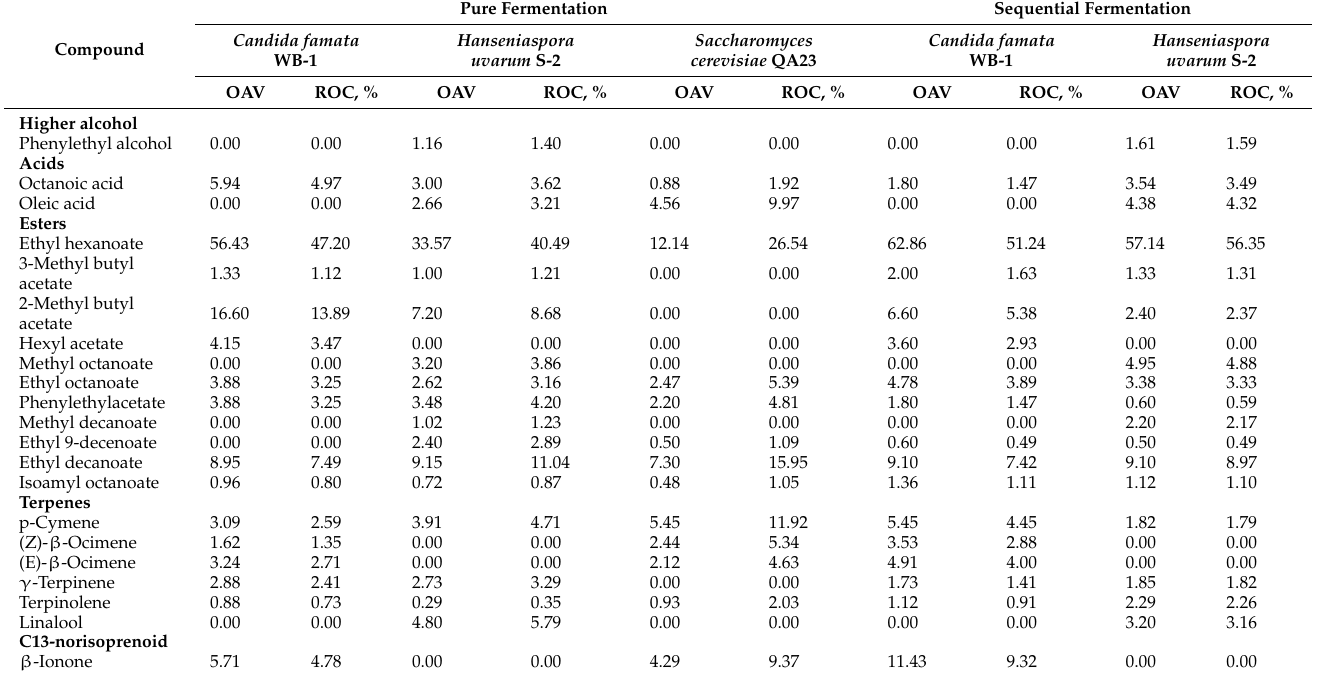
Table 3. Odor activity values (OAV) and relative odor contribution (ROC) of key aroma compounds in Tamjanika wine